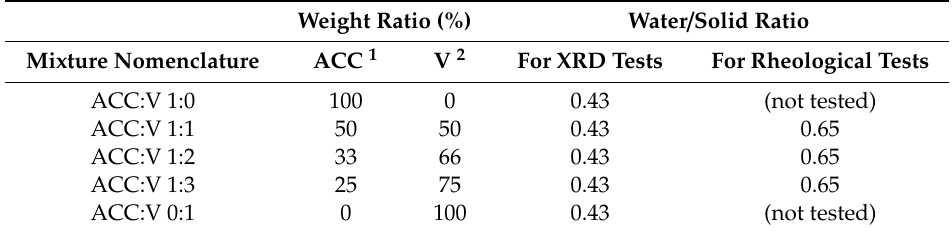
Table 1. Cement mixture nomenclatures, weight ratios of solid precursors and water / solid ratio used for each